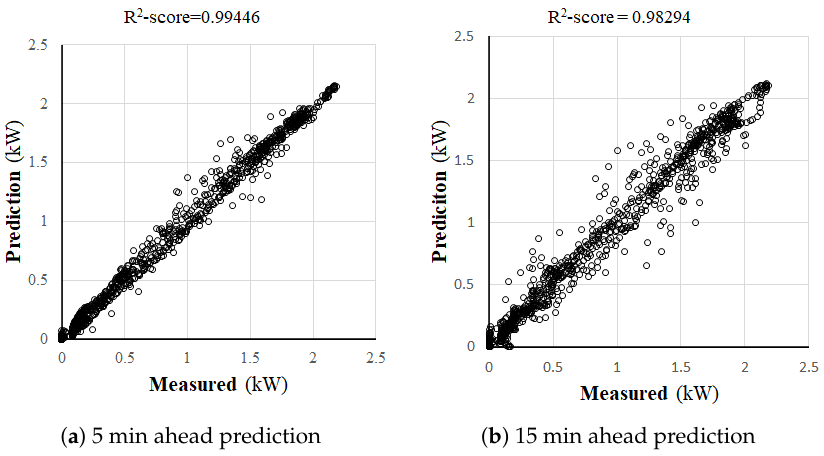
Figure 12. Scatter graph of the very short-term forecast results (RNN layers = 3, time steps = 12). Table 6. Results of short-term forecast errors of PV power